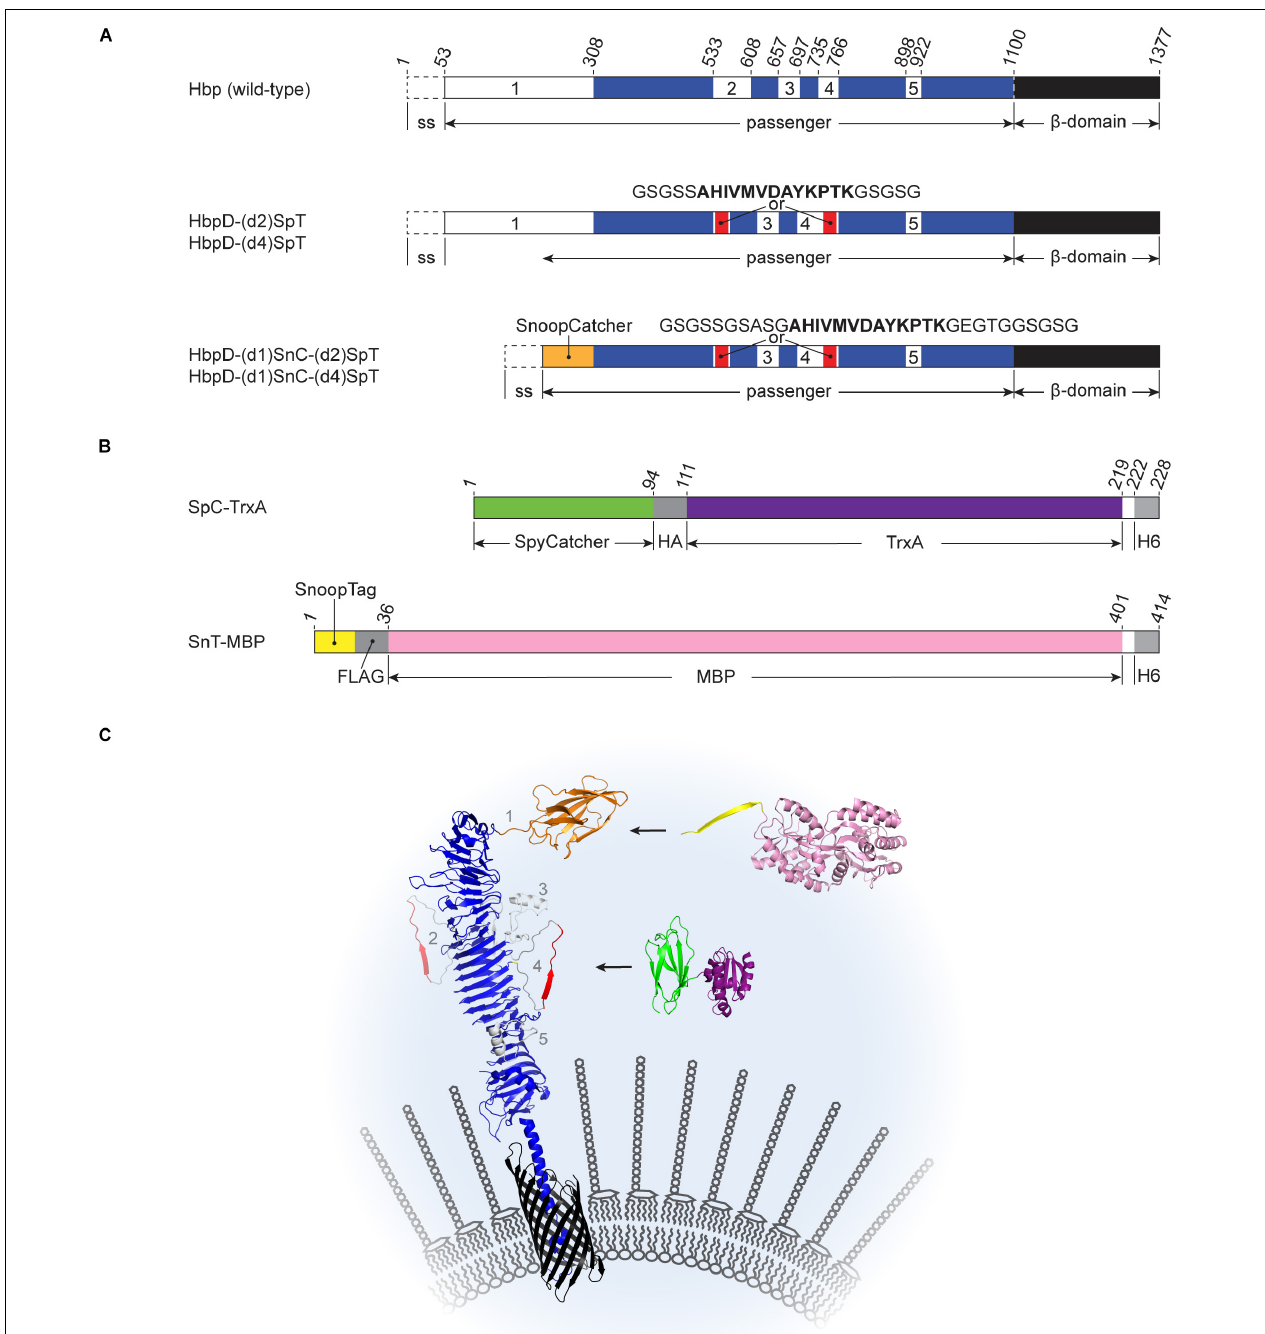
FIGURE 1 | Schematic representations of Hbp derivatives and recombinant proteins used for Spy- and Snoop-based coupling at the surface of OMVs (A) Hbp fusions. Wild-type Hbp is synthesized with an N -terminal signal sequence (ss) that is cleaved off after translocation across the inner membrane. The C -terminal β -domain (black) integrates into the outer membrane, facilitating translocation of the passenger domain. After translocation, autocatalytic cleavage separates the passenger and the β -domain (after Asn1100). The passenger domain contains five subdomains (white, numbered 1 to 5) protruding from a β -helical stem structure (blue). The derived HbpD-(d2)SpT display platform lacks the autocatalytic cleavage site and contains a SpyTag instead of domain 2. In HbpD-(d4)SpT the SpyTag is integrated in domain 4. HbpD-(d1)SnC-(d2)SpT and HbpD-(d1)SnC-(d4)SpT are further derivatives in which domain 1 has been replaced by SnoopCatcher and the linkers surrounding the SpyTag have been extended. (B) Examples of Catcher- and Tag-fused model proteins. HA, HA-tag; H6, hexa histidine-tag; and FLAG, FLAG-tag. (C) Cartoon of Hbp-mediated Spy-and Snoop-ligation to the surface of outer membrane vesicles. HbpD-(d1)SnT-(d2 or d4)SpT is embedded in the membrane of an outer membrane vesicle. The N -terminal SnoopTag is available for ligation with SnC-MBP (SnC, orange; MBP, pink) and the internal SpyTag is available for ligation with SpC-TrxA (SpC, green; TrxA, deeppurple). Positions of subdomains 1–5 as present in the native Hbp passenger are indicated. The protein structure cartoons were assembled from PBD files 1WXR, 3AEH, 4MLI, 2WW8, 5HR3, and 1LLS using PyMOL.